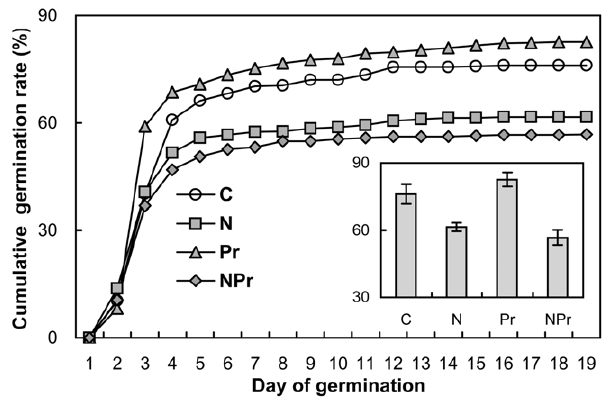
Figure 3. Effects of maternal-treatments on seed cumulative germination rate (%) and final germination percentage (insets, means ± 1SE, n=5). The seeds were collected from the plots with 4 maternal treatments in the field and germinated under the same conditions in the greenhouse. See Figure 1 for abbreviations.